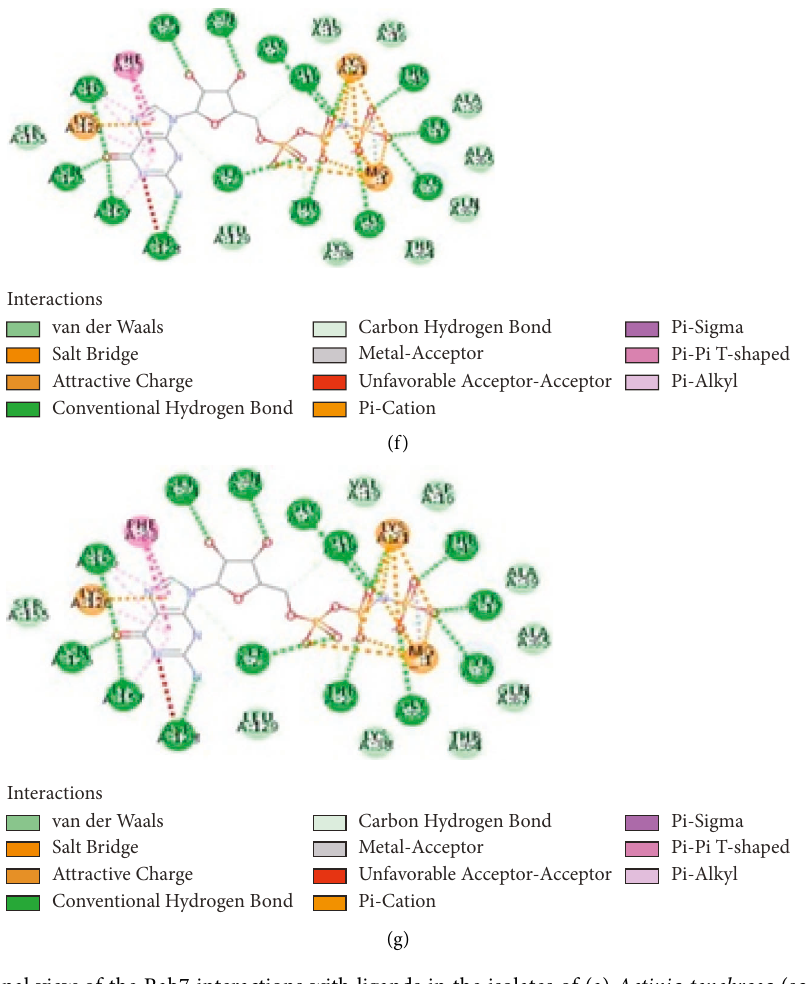
Figure 7: Two-dimensional view of the Rab7 interactions with ligands in the isolates of (a) Actinia tenebrosa (score: 19772), (b) Lingula anatina (score: 16980), (c) Lottia gigantea (score: 18822), (d) Capitella teleta (score: 16084), (e) Priapulus caudatus (score: 18714), (f) Daphnia magna (score: 17952), and (g) Cyprinodon variegatus (score: 17902) after homology modelling.